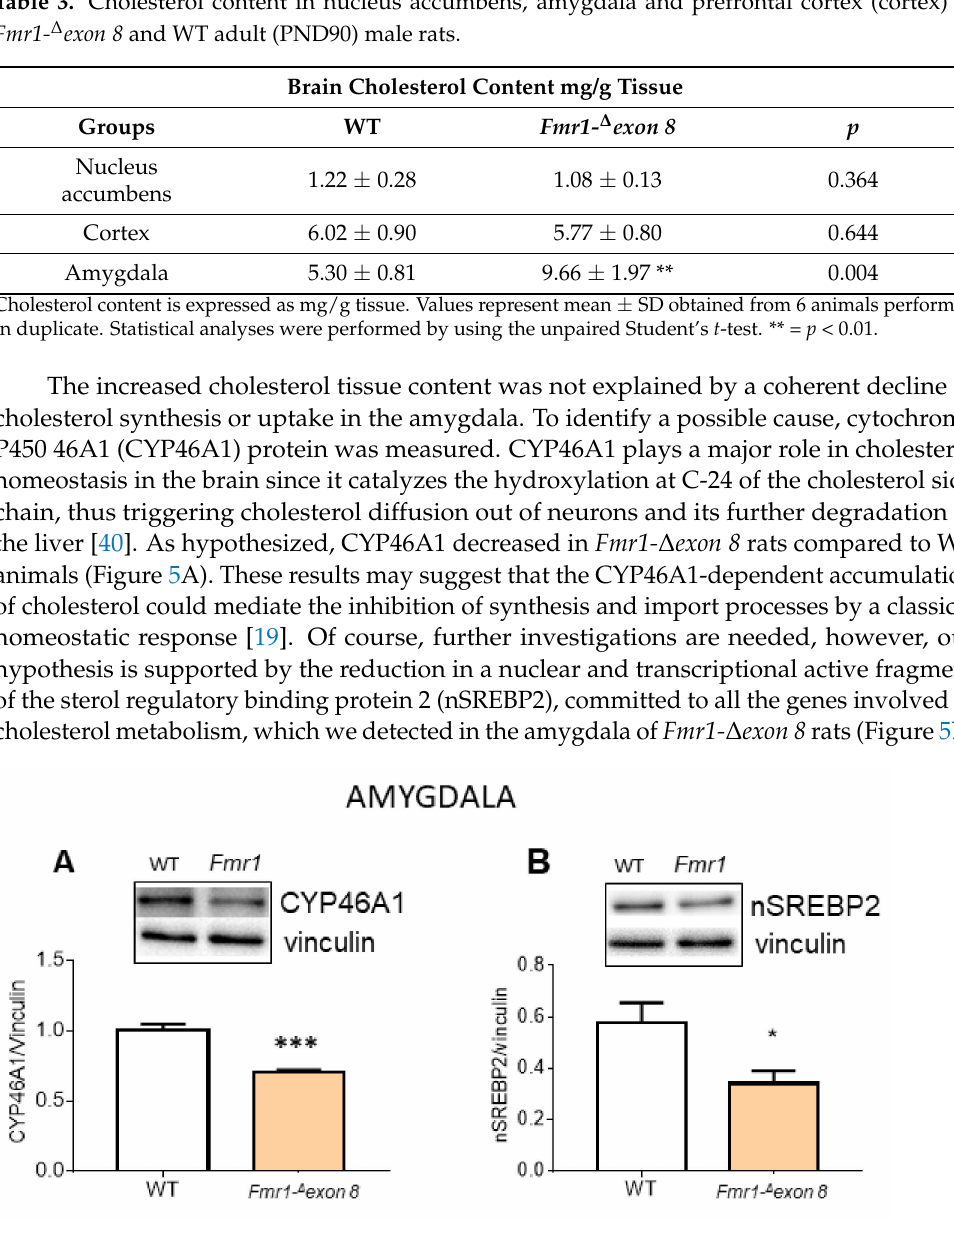
Figure 5. CYP46A1 and nSREBP2 protein level in amygdala of Fmr1- ∆ exon 8 and WT adult (PND90) male rats. ( A ) illustrates a typical Western blot (top) and the densitometric analyses of CYP46A1 in the amygdala of PND90 rats. ( B ) illustrates a typical Western blot (top) and the densitometric analyses of nSREBP2 in the amygdala of PND90 rats. Vinculin served as a housekeeping protein to normalize protein loading. Values represent mean ± SD obtained from 6 animals performed in dupli- cate. Statistical analysis was carried out by using the unpaired Student’s t -test. * = p < 0.05 vs. WT; *** = p < 0.001 vs.